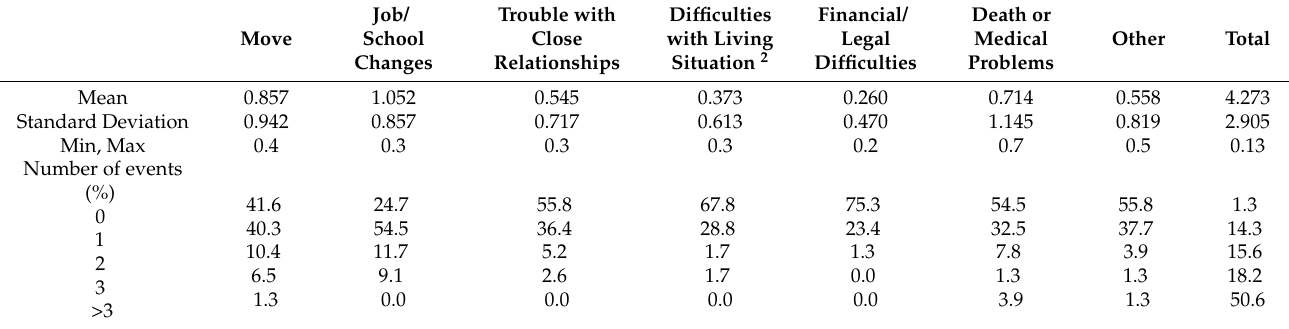
Table 6. Major Life Events 1